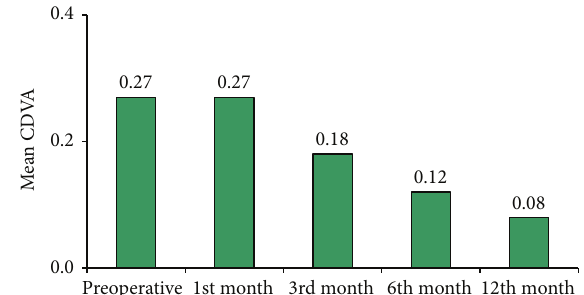
Figure 2: Preoperative and postoperative best corrected distance visual